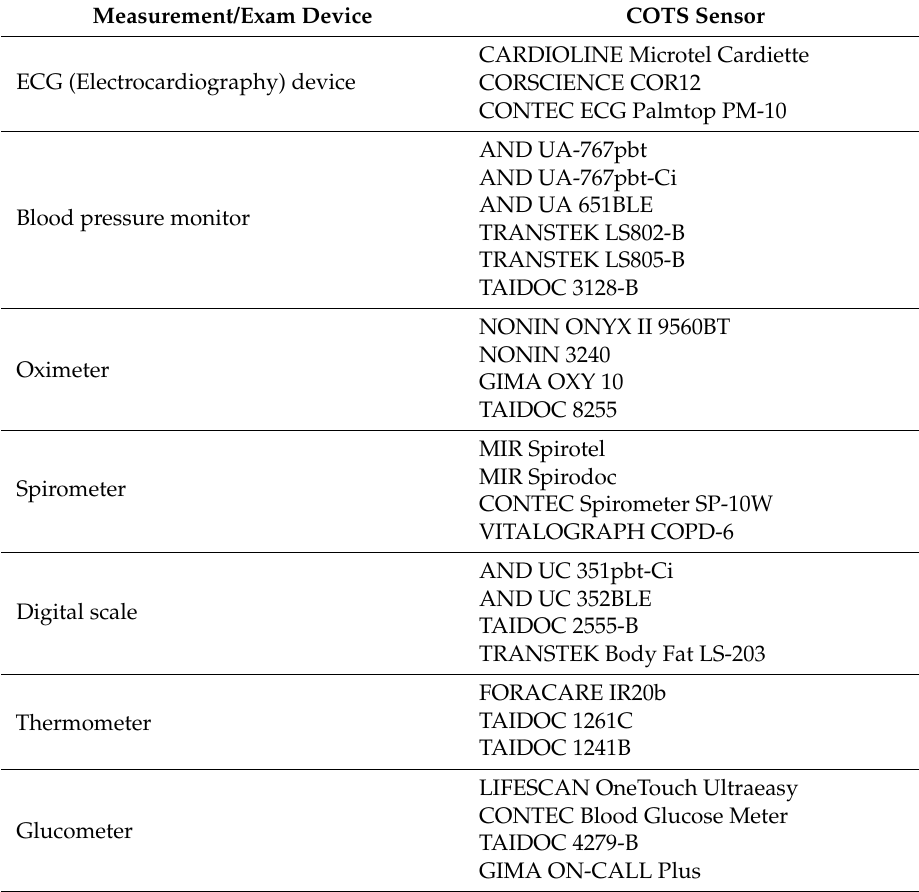
Table 1. List of COTS devices integrated in the